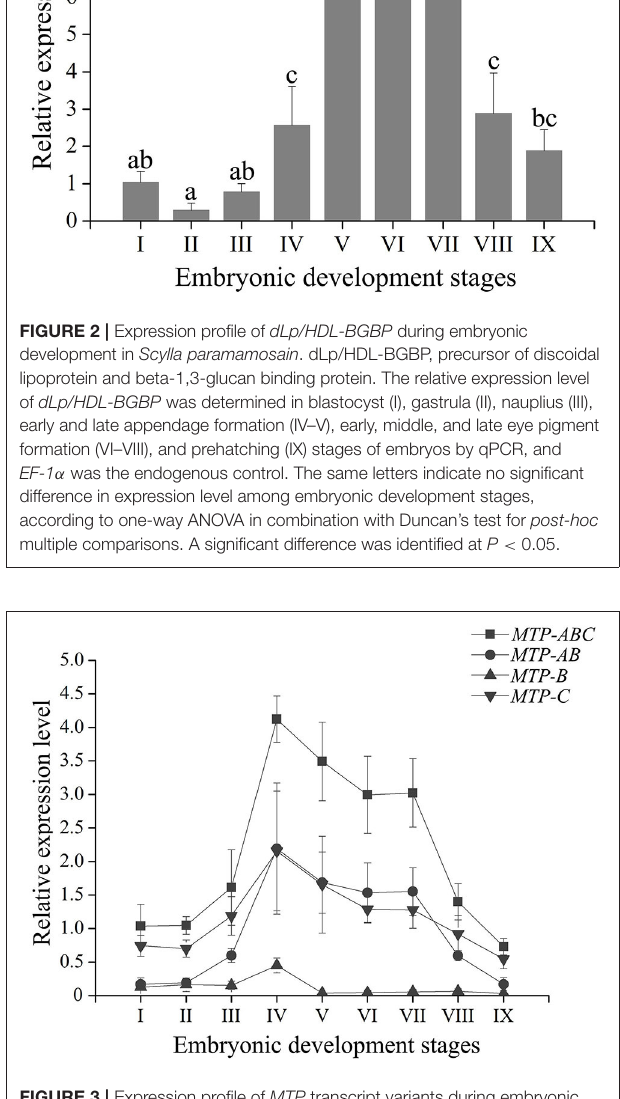
FIGURE 3 | Expression profile of MTP transcript variants during embryonic development in Scylla paramamosain . MTP, microsomal triglyceride transfer protein. The relative expression level of MTP transcript variants was determined in blastocyst (I), gastrula (II), nauplius (III), early and late appendage formation (IV–V), early, middle, and late eye pigment formation (VI–VIII), and prehatching (IX) stages of embryos by qPCR, and EF-1 α was the endogenous control.